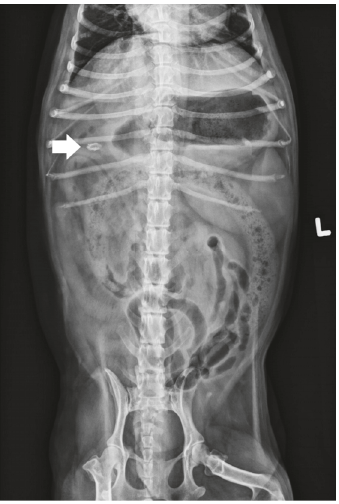
Figure 1: Ventrodorsal radiograph of the abdomen. Note the oval- shaped radiopaque calculi in the right cranial abdomen (white arrow).